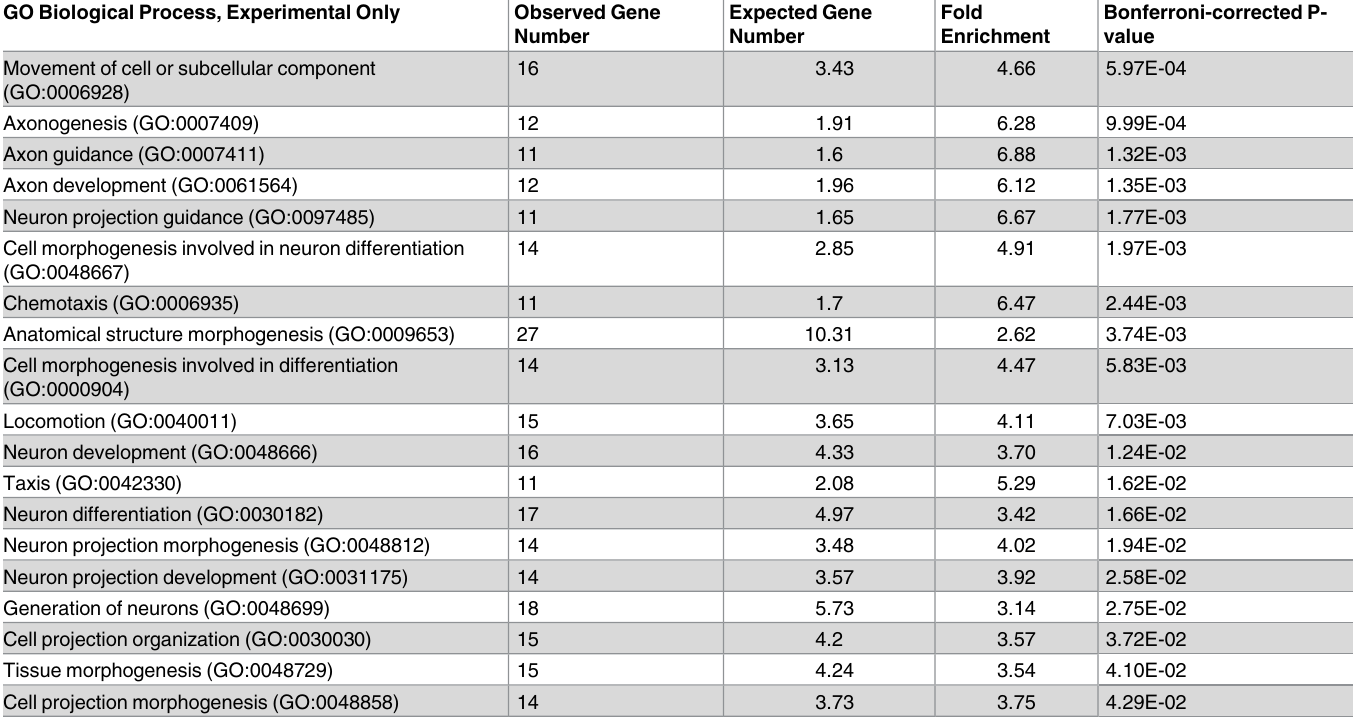
Table 3. GO category enrichment of genes strongly associated with bacterial levels in the fly as calculated by Panther. GO Biological Process, Experimental